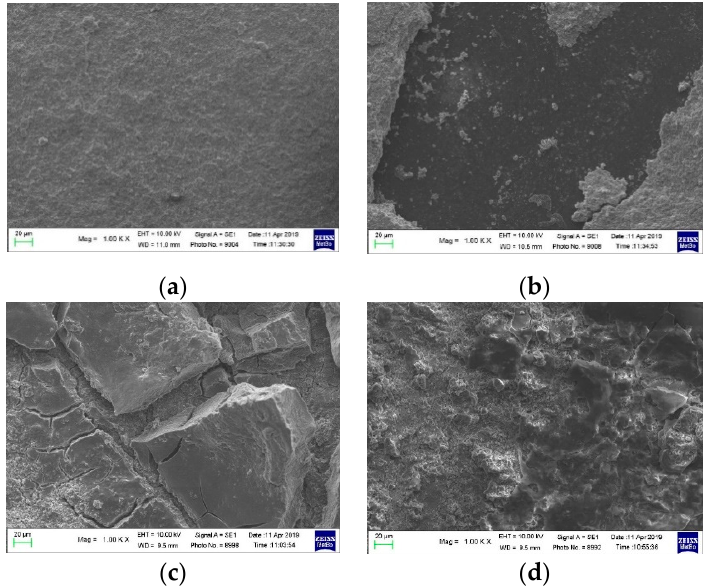
Figure 8. SEM images of ( a ) pristine lithium, ( b ) lithium anode after cycling, separator side toward Li of ( c ) CN01 and ( d ) CN01p cells.